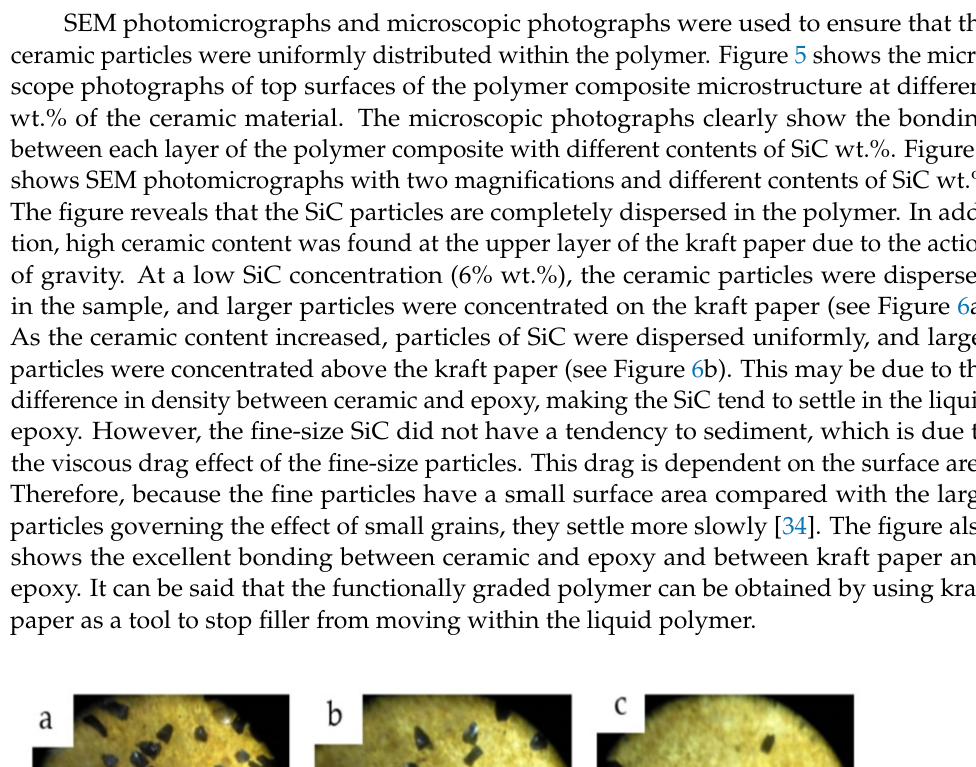
Figure 4. Schematic of the influence of increasing the number of layers on liquid polymer.